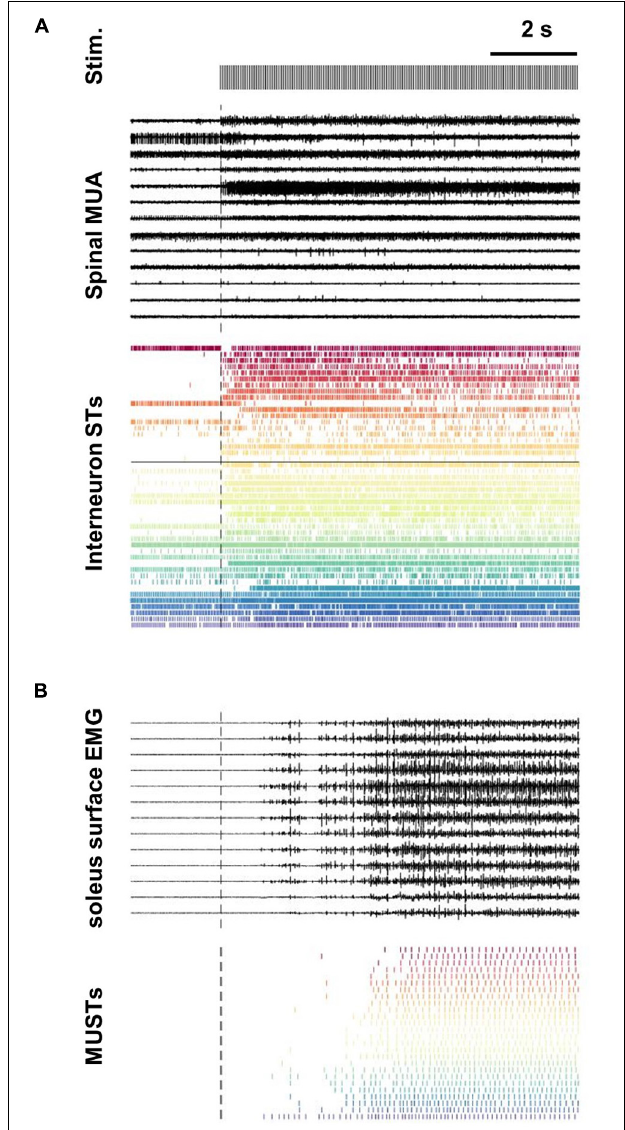
FIGURE 1 | Decomposition of spinal multi-unit and soleus surface electrode array recordings into interneuron and motor unit spike trains. (A) Subset of extracellular recordings (13/128 channels) from L3 and L6 spinal intermediate zones are shown along with the population of all interneurons spike trains (STs) decomposed from the array data ( n = 46). The black horizontal line transecting the interneuron STs separates units decomposed from the L3 ( n = 27) and L6 ( n = 19) arrays. (B) Subset of surface EMG recordings (13/64 channels) along with the population of motor unit spike trains (MUSTs) decomposed from these array data ( n =